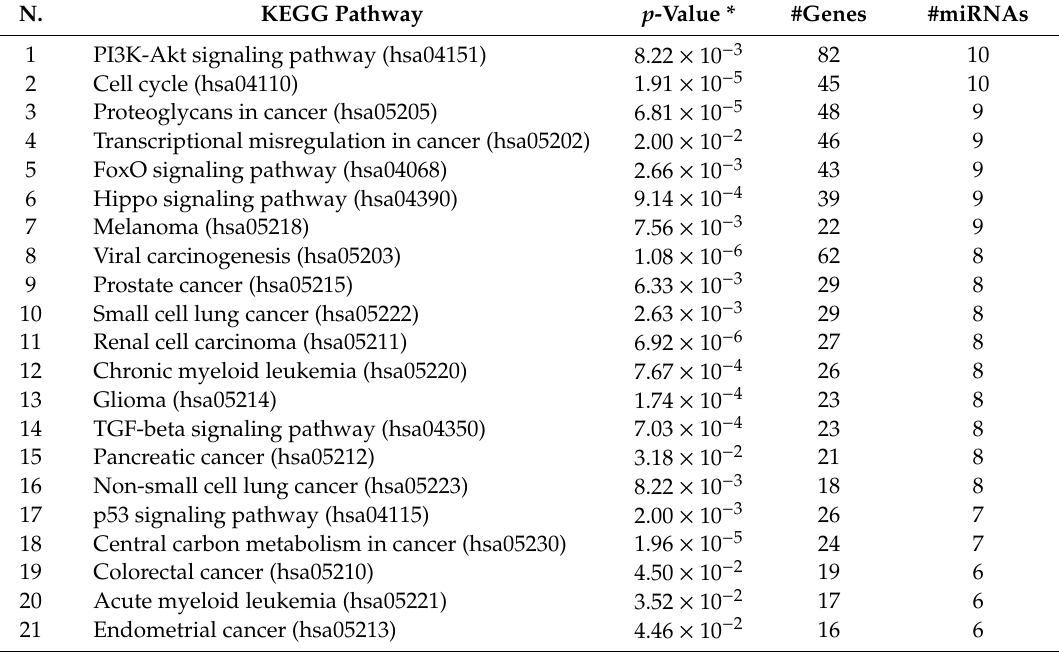
Table 6. Tumor pathways modulated by the 11 computationally selected miRNAs associated to patients’